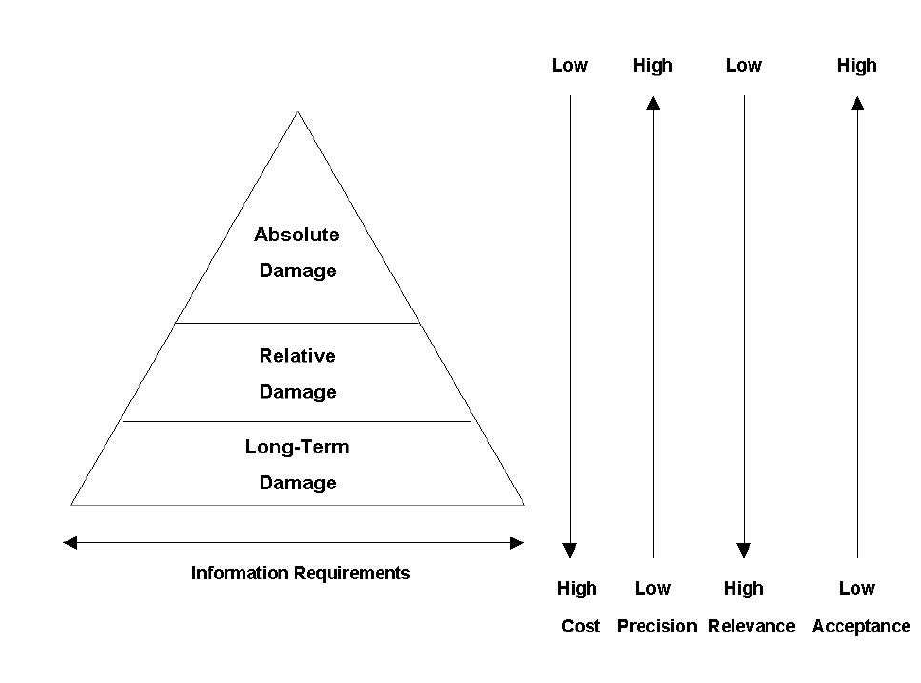
FIGURE 2. Relationships among various Section 316(b) damage assessment